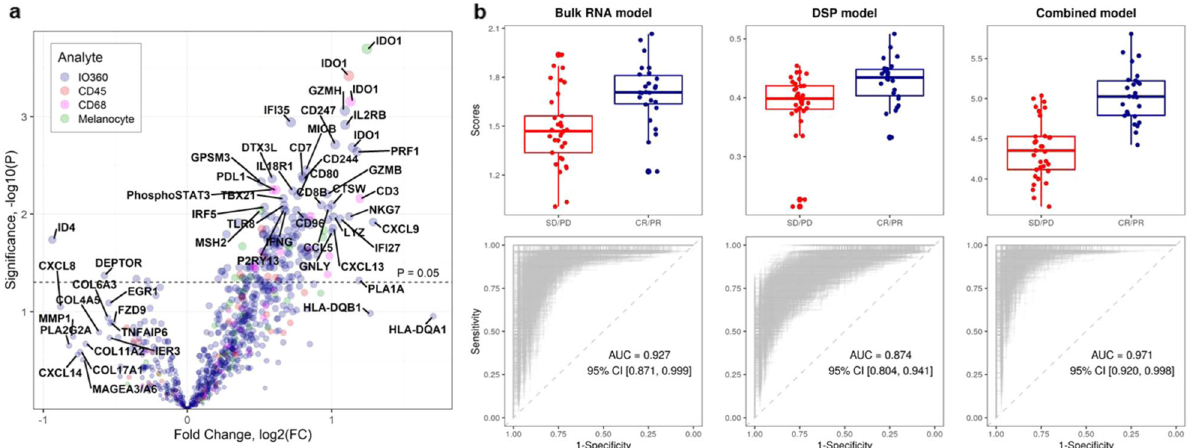
Fig. 2 Combination of mRNA and protein improves best overall response (BOR) classi fi cation. a Identi fi cation of signi fi cant predictors for predictive model generation. Volcano plot showing mRNA and protein variables that are statistically signi fi cant for the prediction of BOR by unadjusted univariate analysis ( p < 0.10, n = 527 variables, p < 0.05, n = 228 variables). b Combined modality model is superior to RNA-only or protein-only models in terms of BOR classi fi cation. Box and whisker plots and receiver operator characteristic (ROC) curves comparing a bulk RNA-only model ( n = 770 variables; Area under the curve [AUC], 0.93; 95% con fi dence intervals [CI], 0.87 – 1.00; sensitivity, 0.93; speci fi city, 0.87; positive predictive value [PPV], 0.85; negative predictive value [NPV], 0.94) with a DSP-only model ( n = 117 variables; AUC, 0.87; 95% CI, 0.80 – 0.94; sensitivity, 0.79; speci fi city, 0.88; PPV, 0.84; NPV, 0.84) and a combined bulk RNA and DSP model ( n = 44 variables; AUC, 0.97; 95 CI, 0.92-1.00; sensitivity, 0.96; speci fi city, 0.93; PPV, 0.91; NPV, 0.96); feature selection occurs through Elastic Net Regularization after removal of moderately correlated predictors ( R 2 > 0.70). On each boxplot, the central line indicates the median and edges indicate the interquartile range. The upper whisker extends from the 75th percentile to the largest value at most the 1.5x interquartile and the lower whisker extends from the 25th percentile to the smallest value at most the x1.5